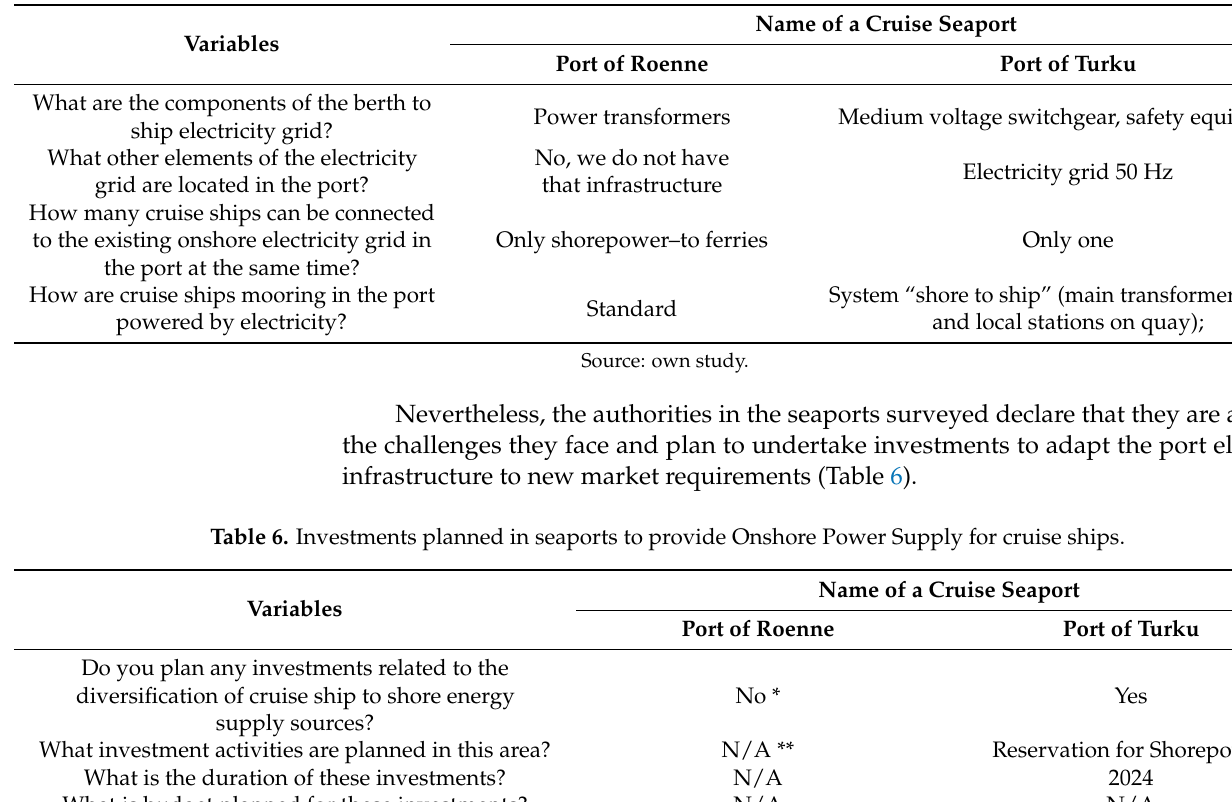
Table 5. Seaport readiness to provide Onshore Power Supply for cruise ships.